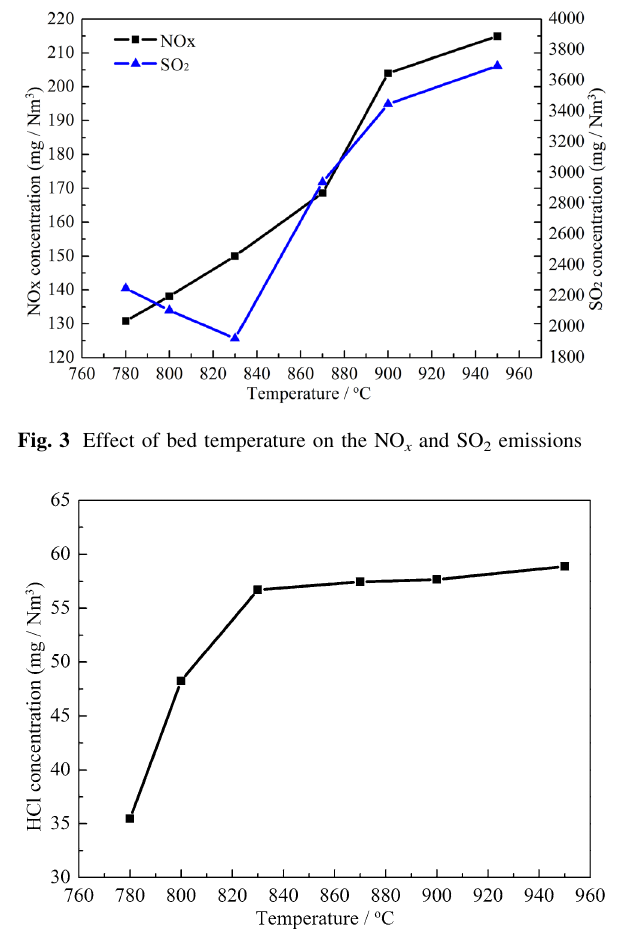
Fig. 5 Effect of MSW blend ratio on the CO emission and carbon content in